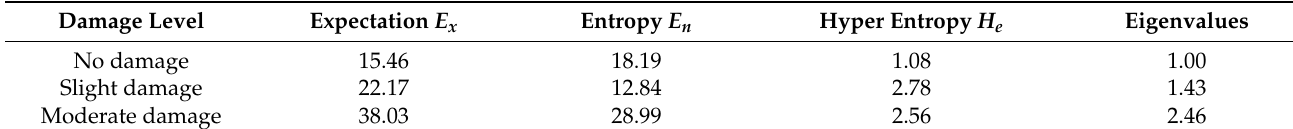
Table 7. Eigenvalues of different damage levels by normalization processing.